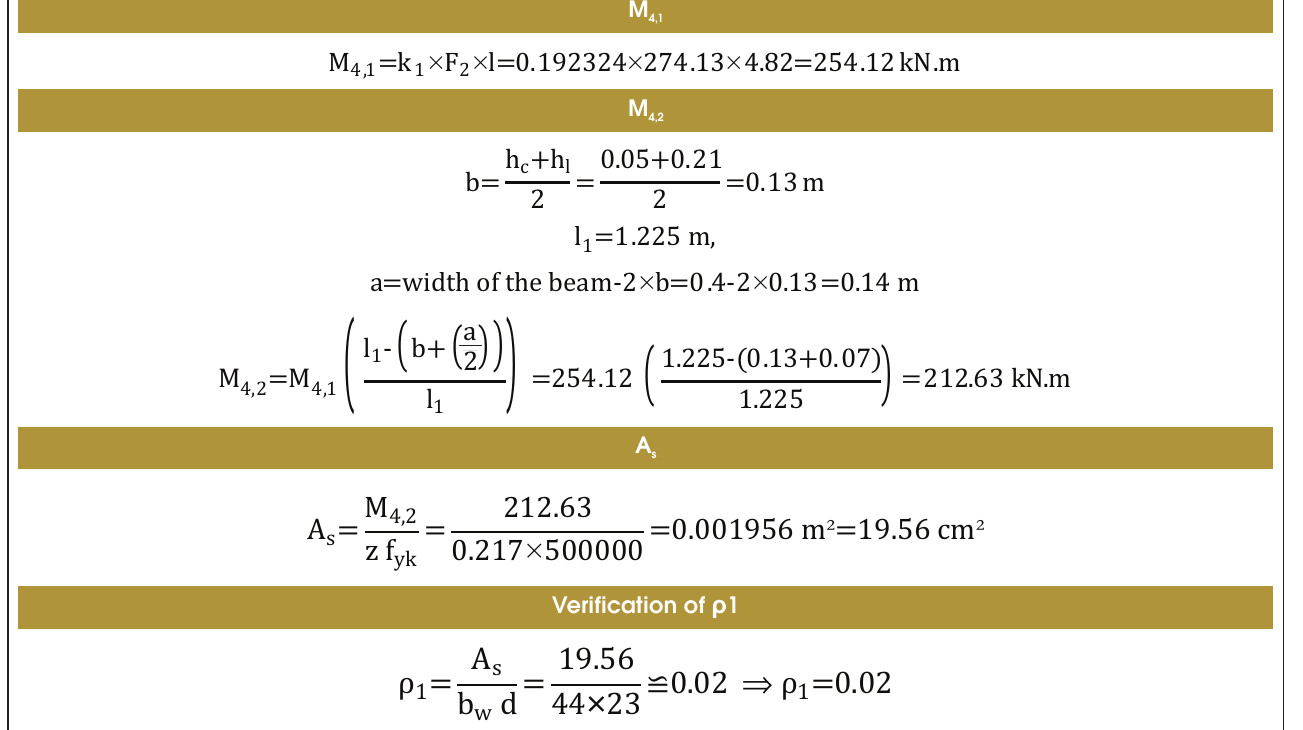
Table 13 – Calculation of the continuity reinforcement bars (As) for flexural, limited by verification of shear